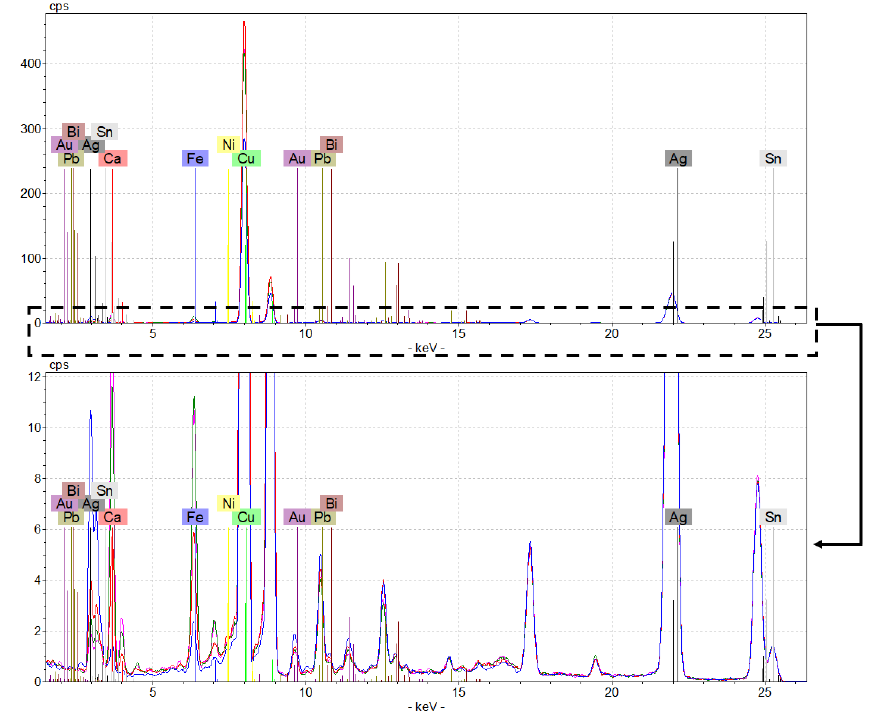
Figure 1. Four overlapped μ -EDXRF spectra of the coin no. D27. Spectrum of recto_1 in pink, recto_2 in blue, verso_1 in red, and verso_2 in green. The lower spectrum is relative to the area within the dashed frame, so that even the lower intensity peaks can be appreciated.